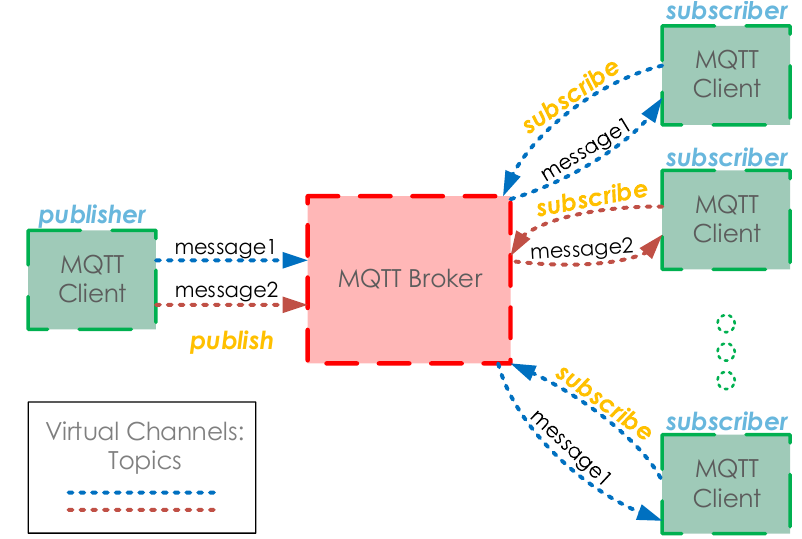
Figure 1. Main entities of the Message Queuing Telemetry Transport (MQTT)